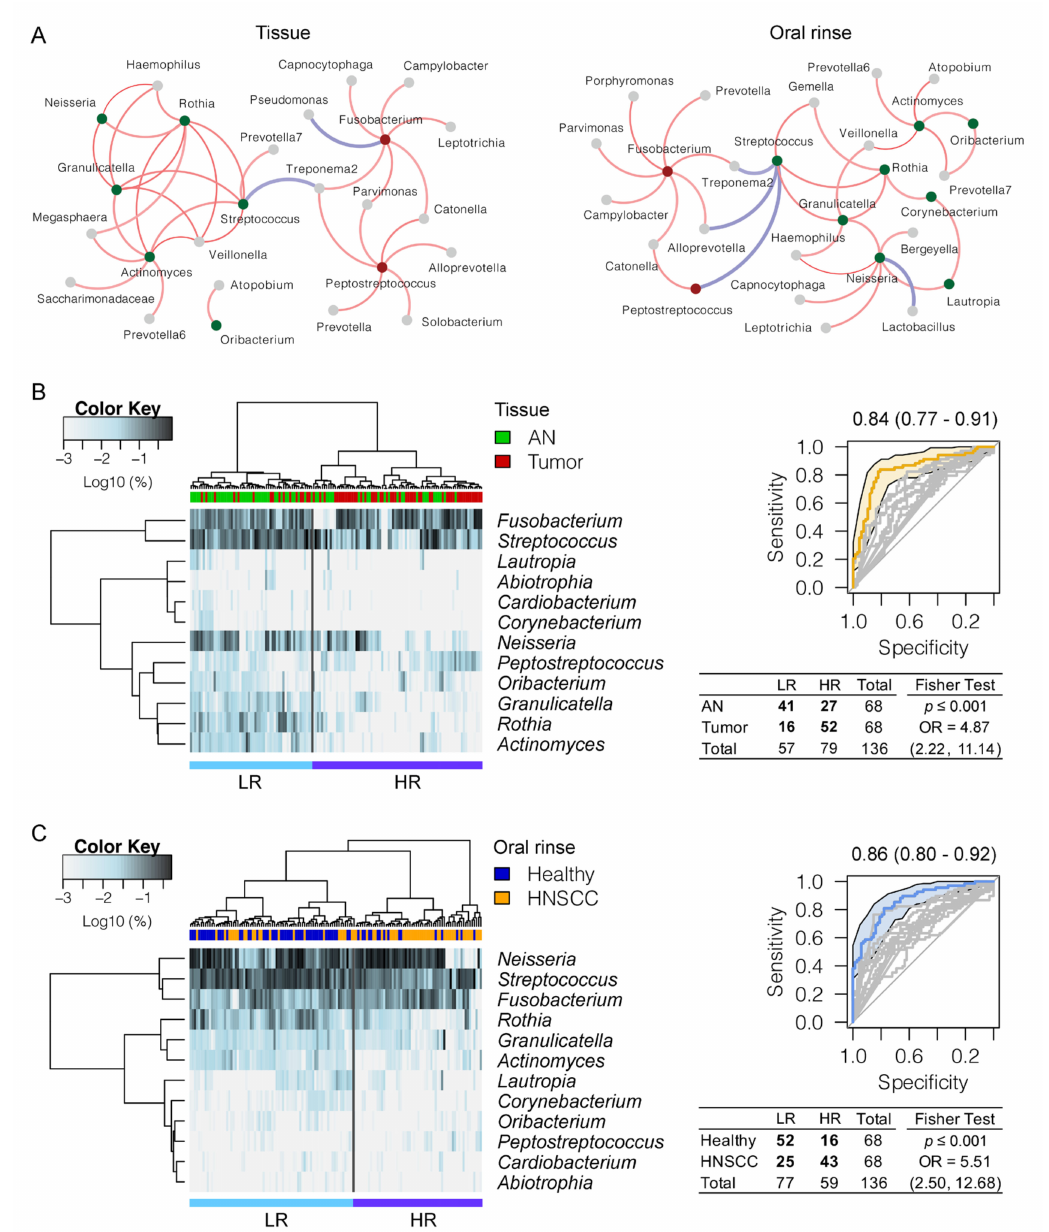
Figure 2. A refinement of twelve “core” bacterial genera discriminating HNSCCs from controls. ( A ) A SparCC correlation analysis ( r ≥ 0.3, p ≤ 0.01) showing connections between pathogen–pathogen, nonpathogen–nonpathogen, and pathogen–nonpathogen bacteria. Grey dots indicate bacterial genera with no significant di ff erences in abundance between HNSCC and controls. Red and green dots indicate bacterial genera enriched in HNSCCs and controls, respectively. Connections with red and blue lines indicate collaborative and inhibitive relationships, respectively. Hierarchical cluster analyses of tissues ( B ) and oral rinses ( C ) using distance matrix of 12 discriminative bacterial genera classified oral microbial communities into two clades, namely, high-risk and low-risk, based on the dendrogram topologies. The receiver operating characteristic (ROC) analysis of combined twelve genera achieved AUCs of 0.84 and 0.86 in tissues and oral rinses, respectively. Clustering between the two groups was evaluated using a two-tailed Fisher exact